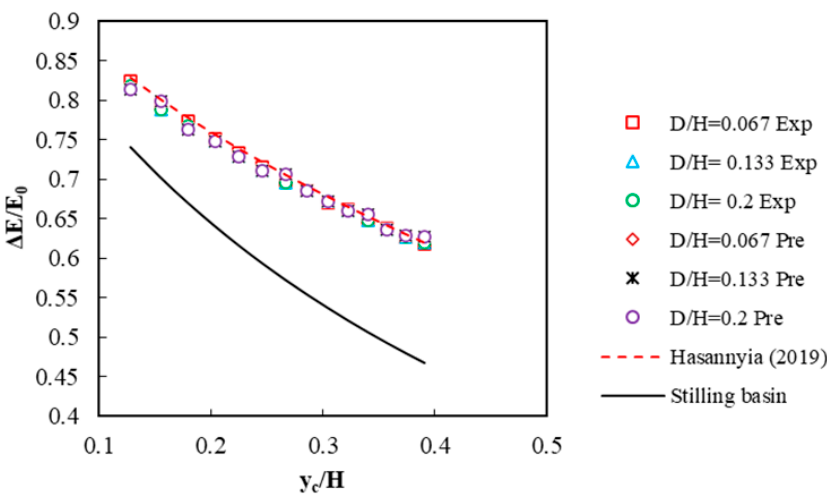
Figure 6. Variation of relative energy dissipation versus relative critical depth.